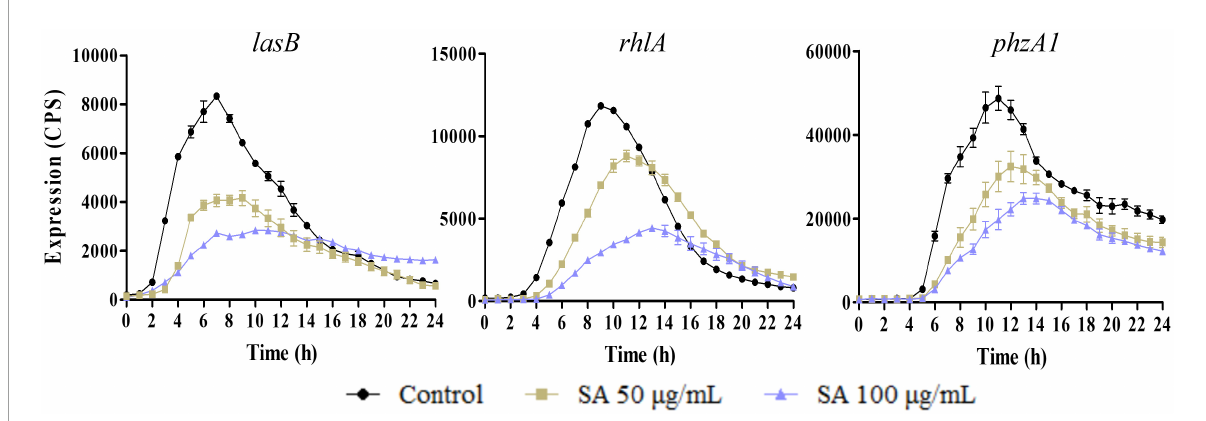
FIGURE3 Inhibition of SA on the expression of virulence factor encoding genes ( lasB , rhlA , and phzA1 ). All data were expressed as mean ± SD values with three independent experiments performed in triplicate.